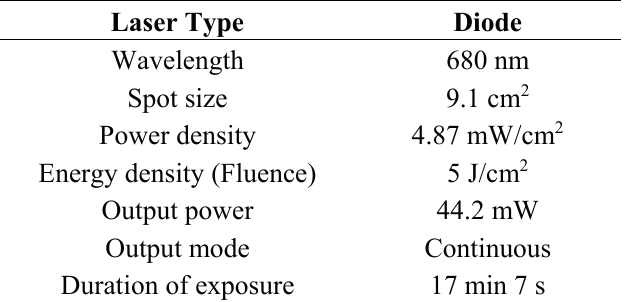
Table 2. Laser irradiation